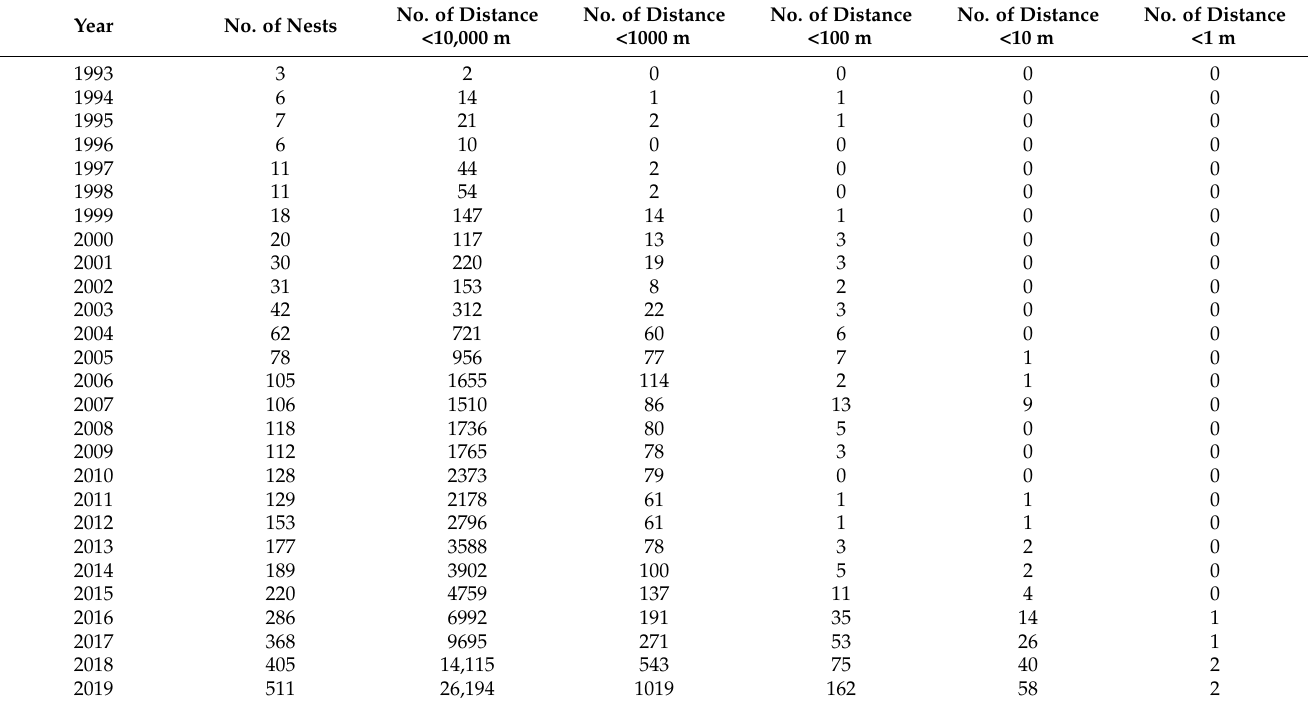
Table 3. The number of cases that the distance between every two nests is less than a series of thresholds indicating the number of neighboring nests in each year.